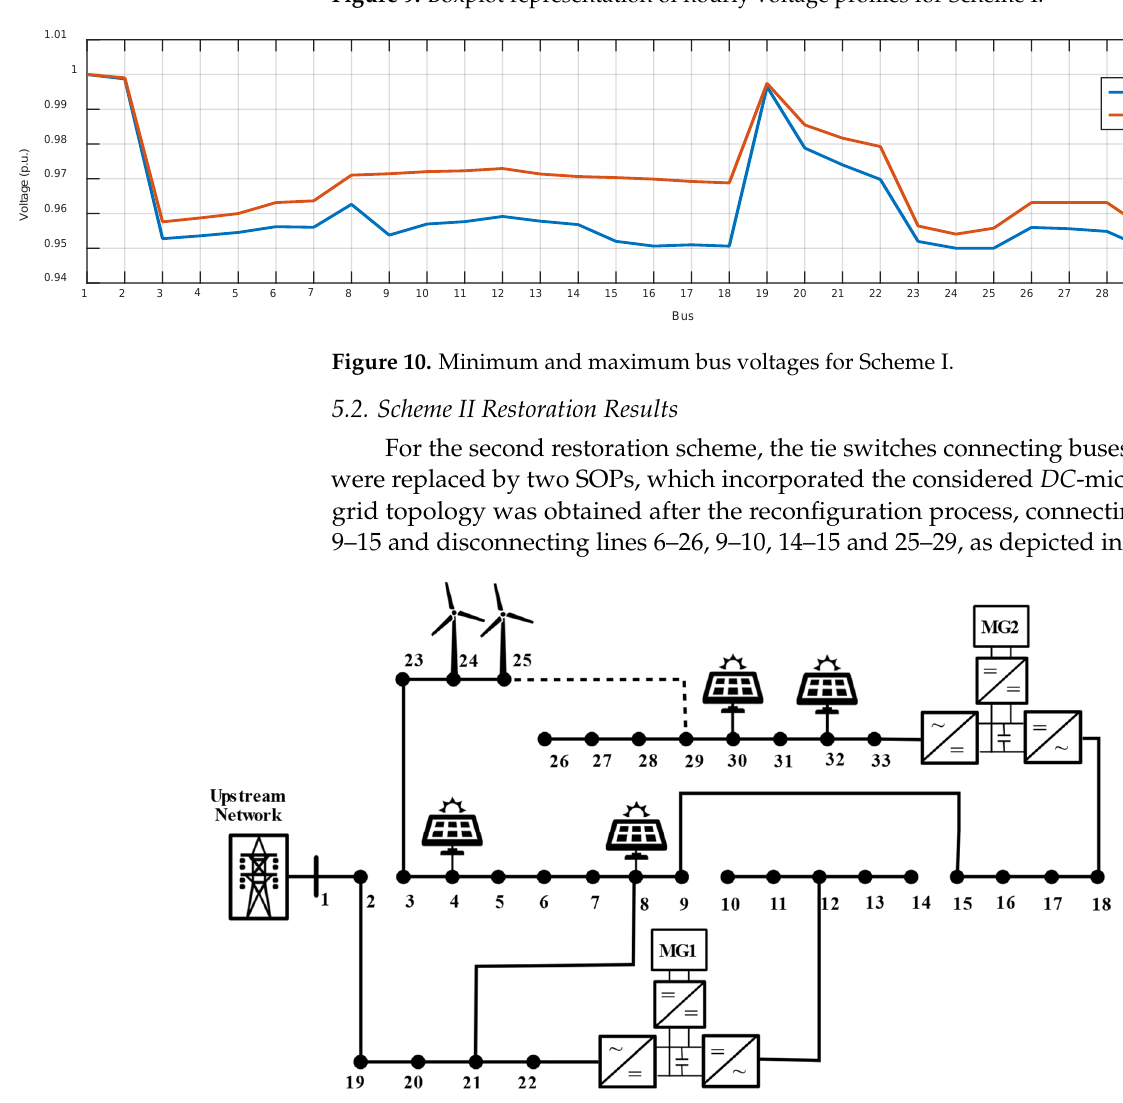
Figure 11. Restoration results for Scheme II.